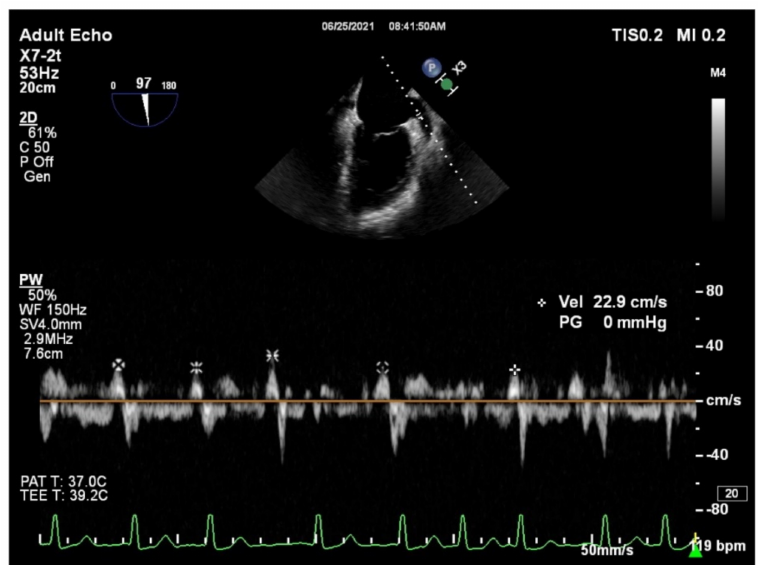
Figure 1. Example of measuring the left atrial appendage emptying velocity (LAAeV). The LAAeV was measured by pulsed-wave Doppler interrogation at the entry of the left atrial appendage at 84 ◦ (22.9